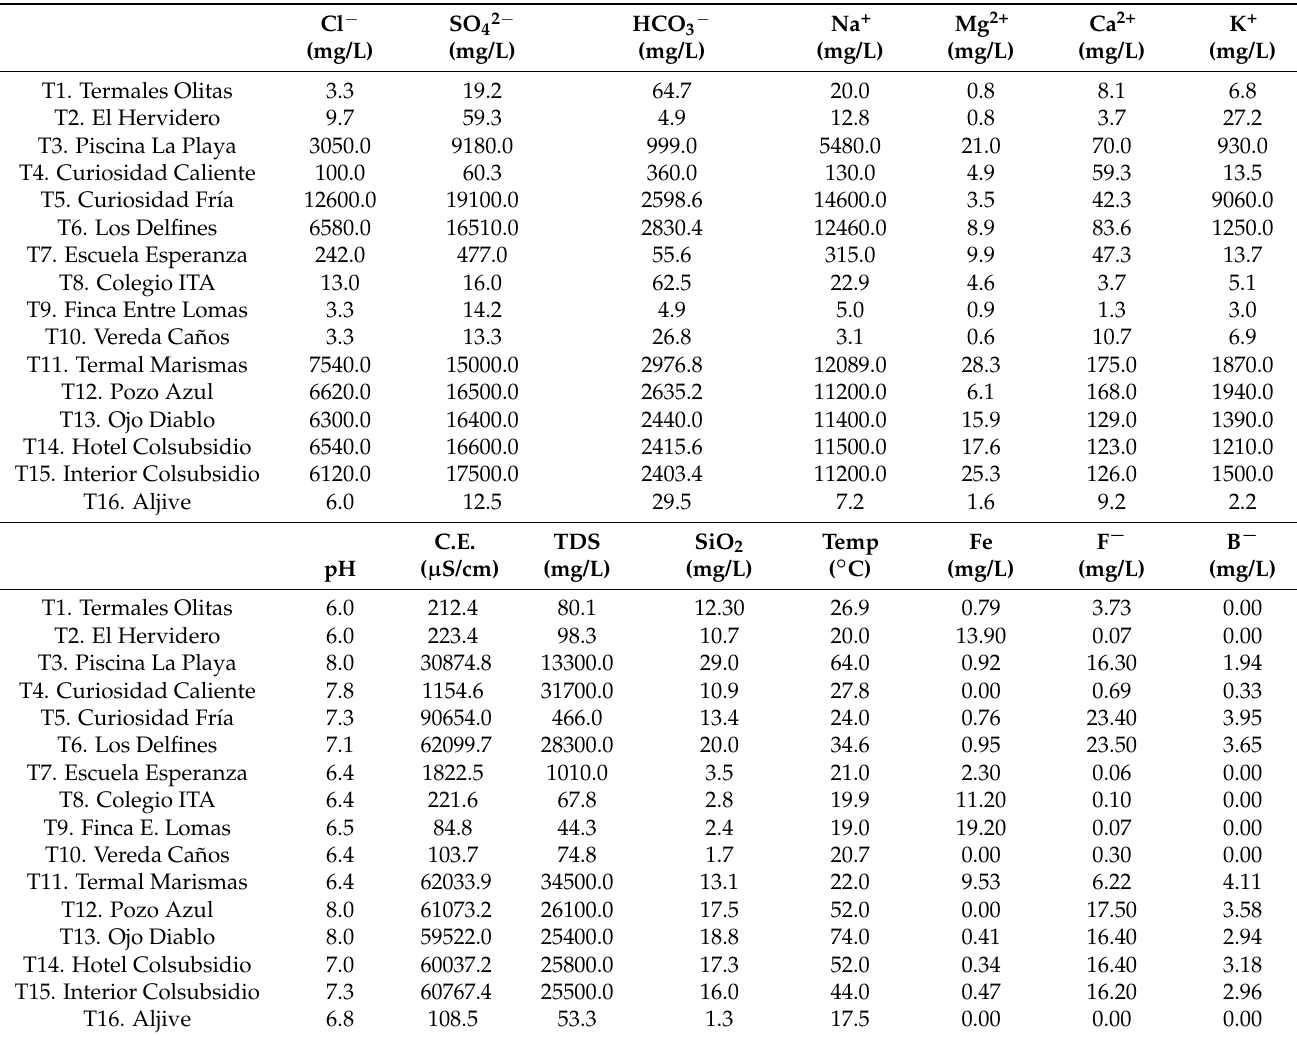
Table 3. Water sampling points in the Paipa geothermal area.